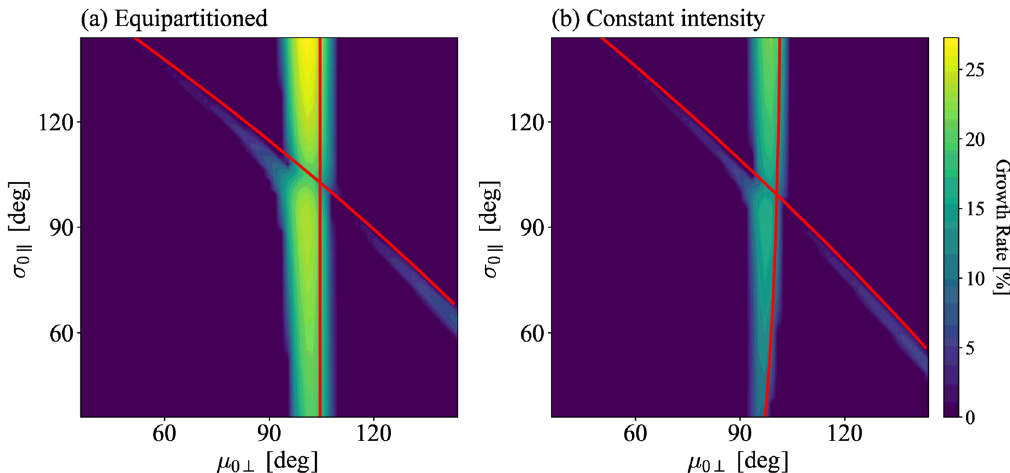
FIG. 3. Linear-mode stability predicted by the 3D rms envelope equations. Red lines indicate the positions of the second-order ( m ¼ 2 ) resonances expected from Eq. (6) with C 2 ¼ 0 . 7 . In the left panel (a), the equipartitioning condition is applied over the whole tune space with the transverse tune depression η ⊥ fixed at 0.8. In the right panel (b), the beam intensity (perveance) is kept unchanged. η ⊥ thus depends on the operating point. The intensity is determined so as to achieve